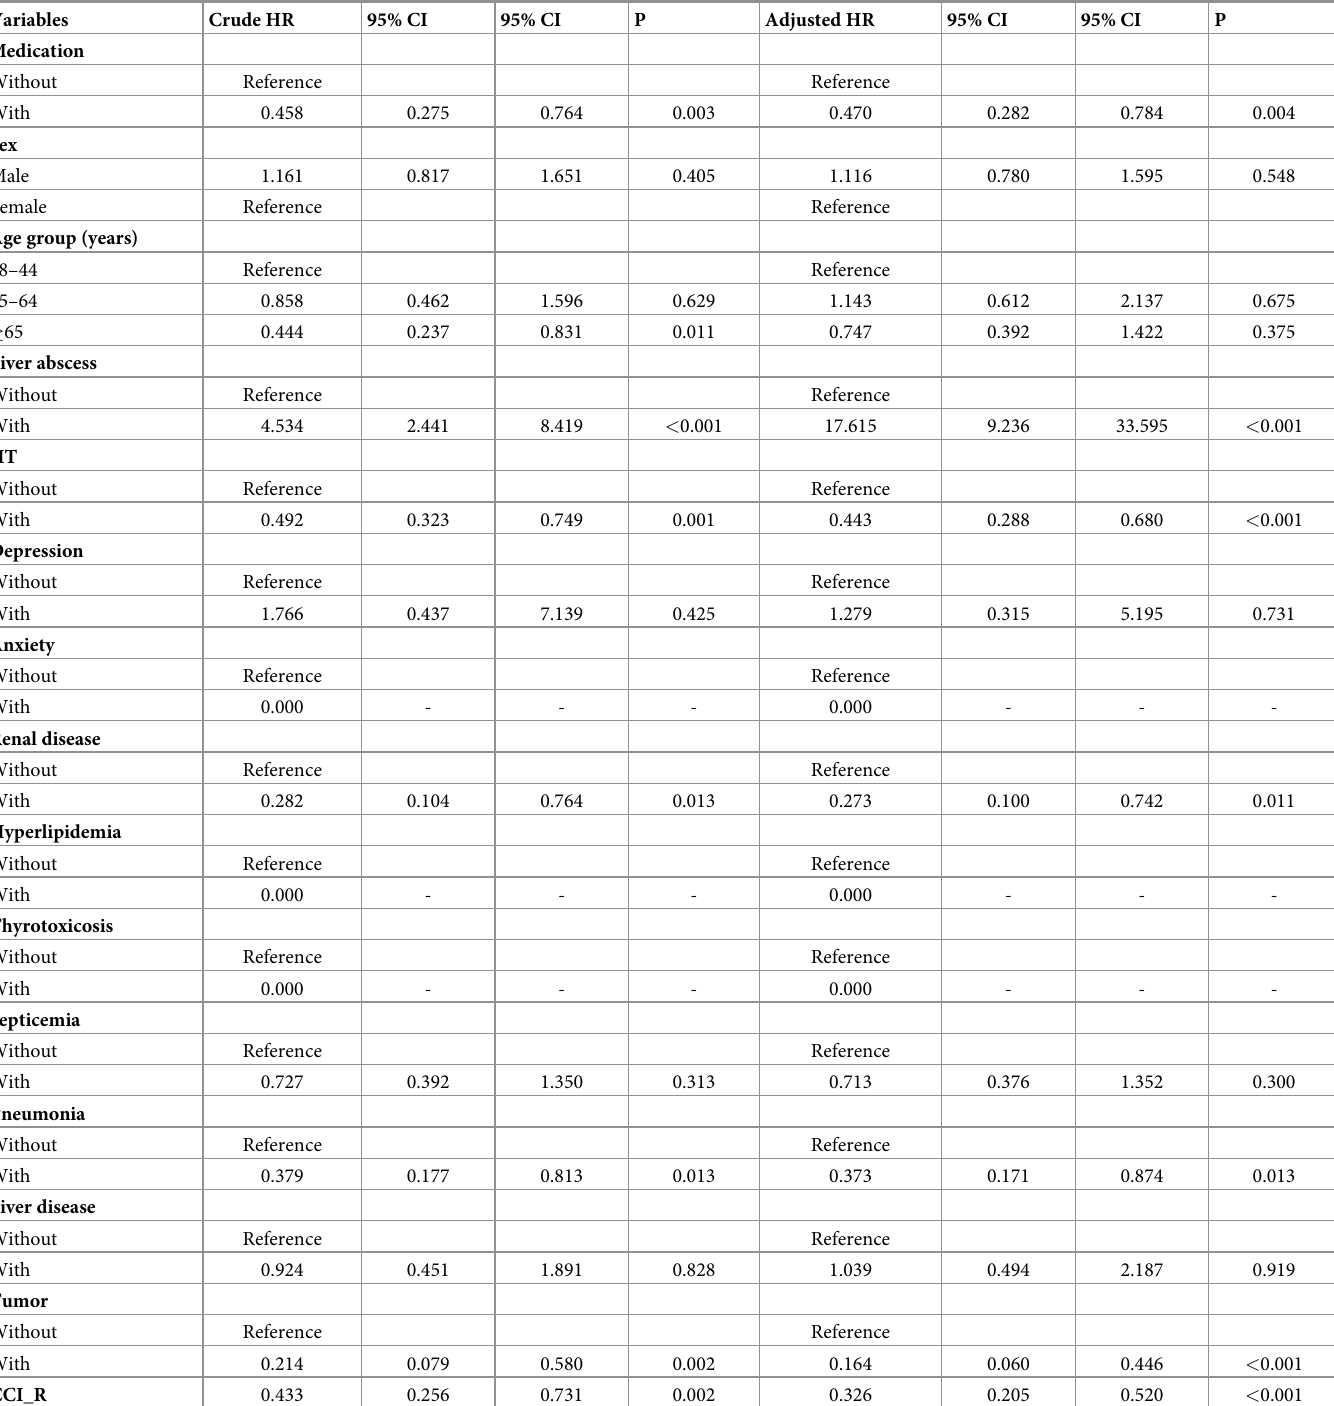
Table 1. Factors of endogenous endophthalmitis determined using cox